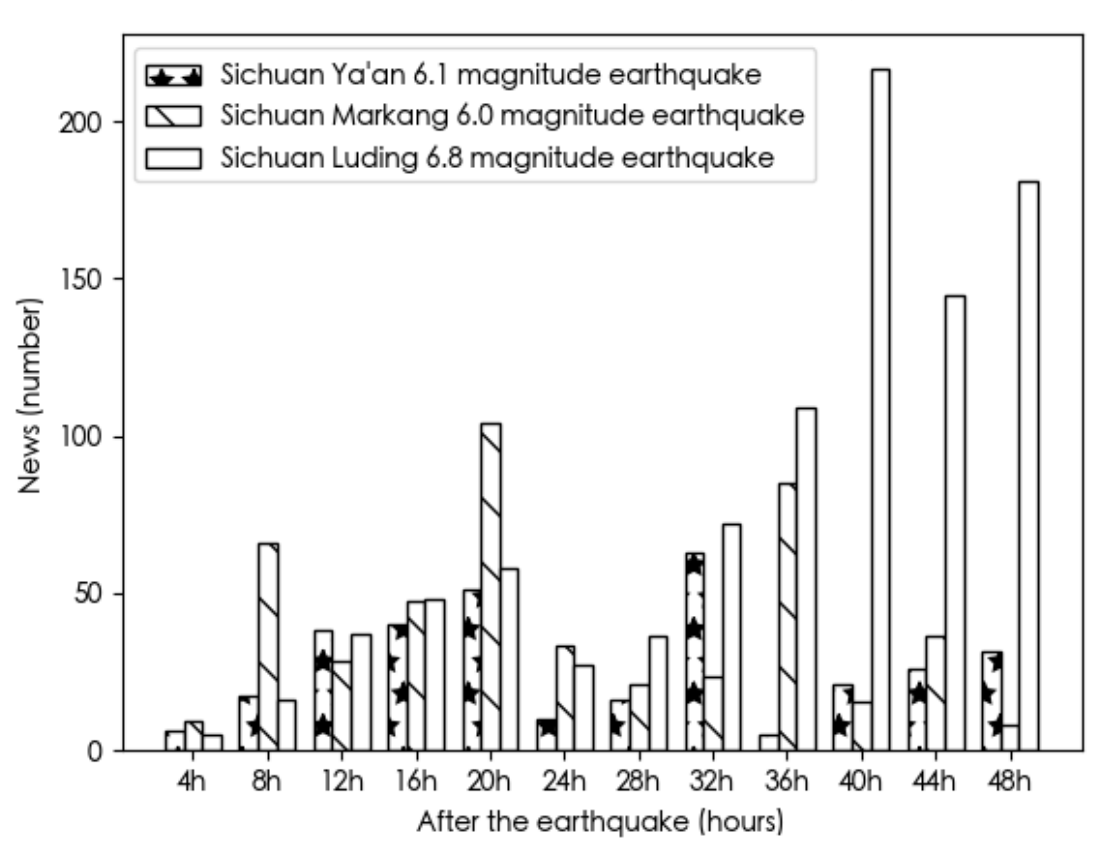
Figure 8. Number of news items obtained after each